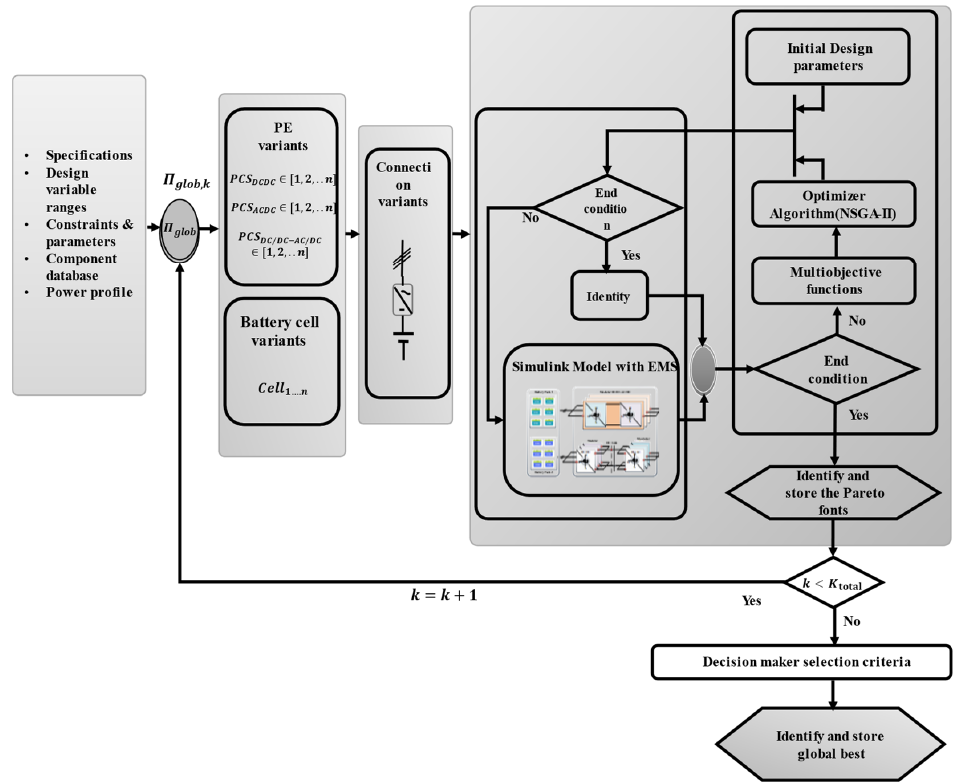
Figure 9. Methodology of COF for sizing and selection of technology toward optimal HBESS design.